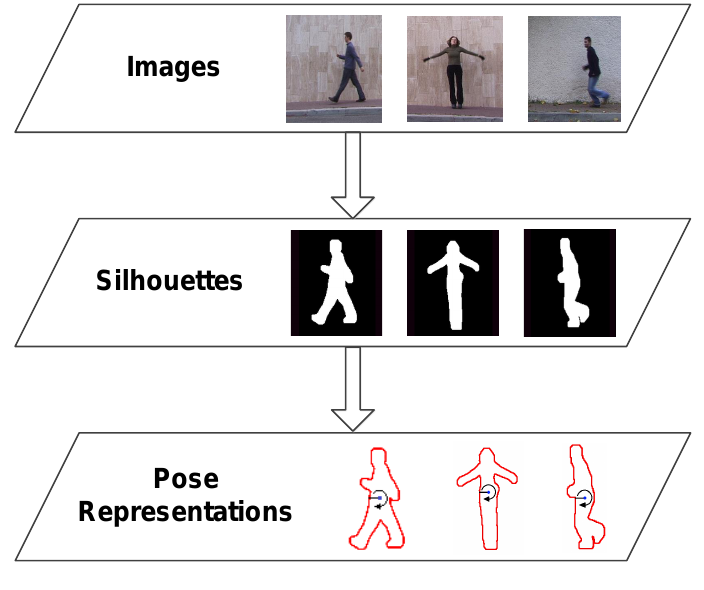
Figure 2. Outline of the pose representation process. Based on the recorded video frames, foreground segmentations are obtained. Relying on the shape of the human silhouettes, a low-dimensional and radial feature is extracted.